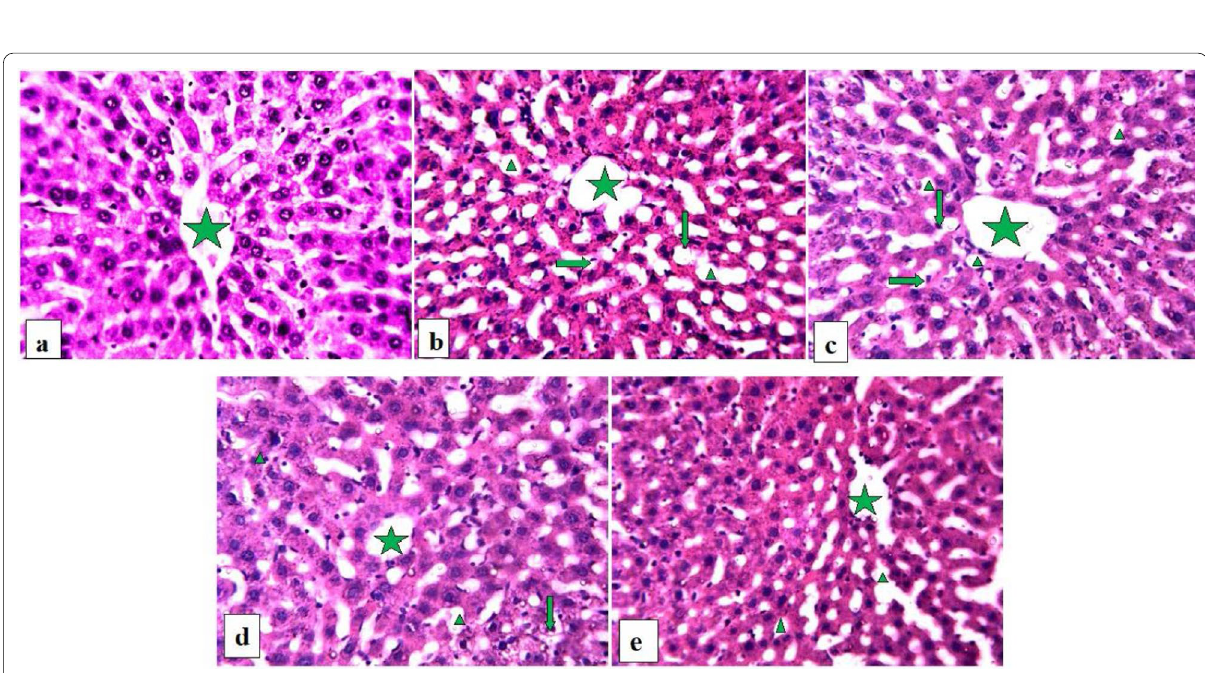
Fig. 3 Photomicrographs of sections of liver of a control ( a ) showing normal histological structure of the liver with the central vein (star), Lead acetate treated micrograph ( b ) showing marked steatosis (arrow) and some macro vesicular fatty change (arrow head), Extract 250/500 mg/ kg lead acetate 30 mg/kg ( c , d ) respectively showing mild steatosis (arrow) and some macro vesicular fatty change (arrow head), Succimer 5 mg/ + kg lead acetate 30 mg/kg micrograph ( e ) showing mild macro vesicular fatty change (arrow head). H&E stained X 250, n +